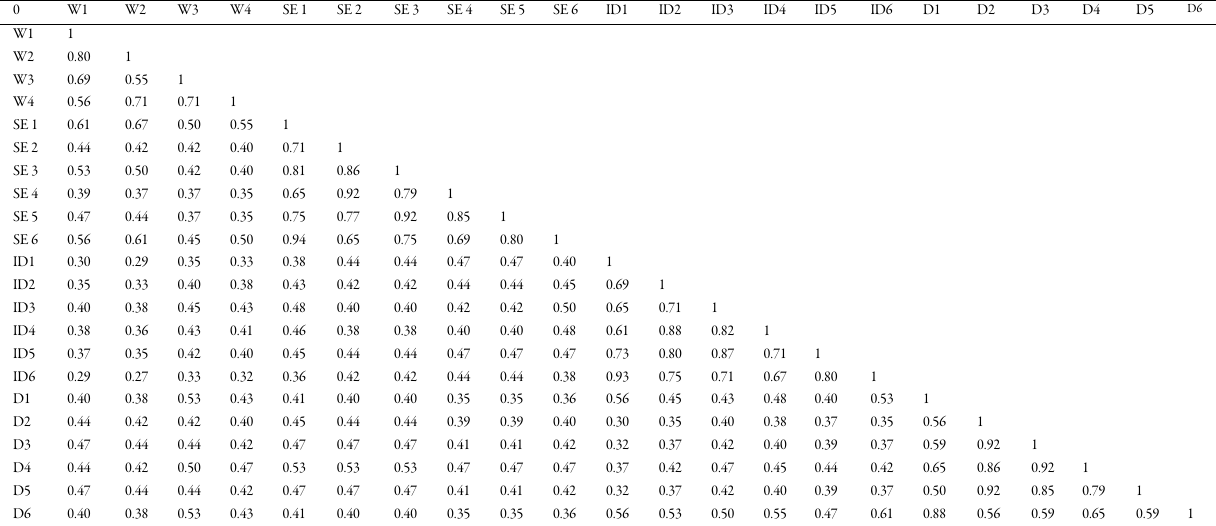
Table 6. Jaccard’s similarity coefficient based on cpSSR dataof the in vitro propagated shoots through SE=Somatic embryogenesis, D=Direct organogenesis, ID=Indirect organogenesis and W=wild plant 0